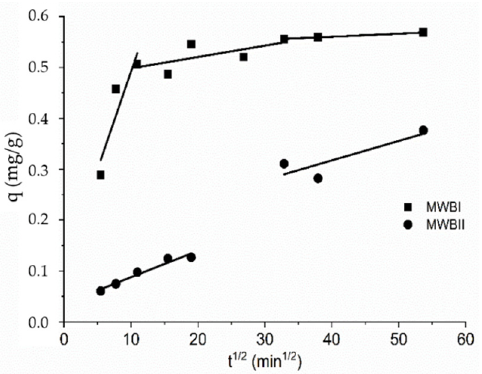
Figure 7. The Weber Morris model for sorption of Be(II) onto MWBI and MWBII from aqueous solution.